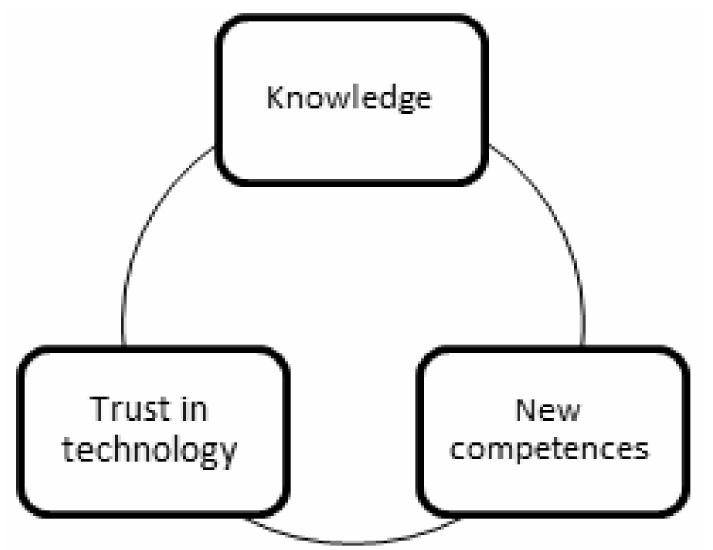
Figure 1. Research assumptions. Source: the